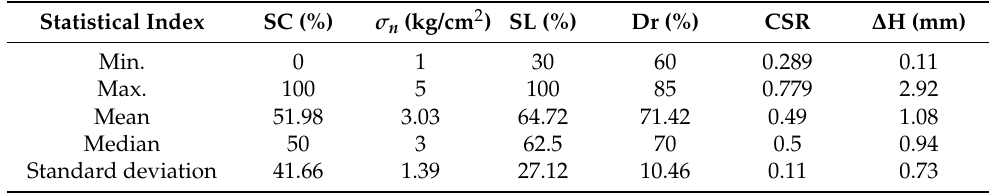
Table 1. Statistical features of training